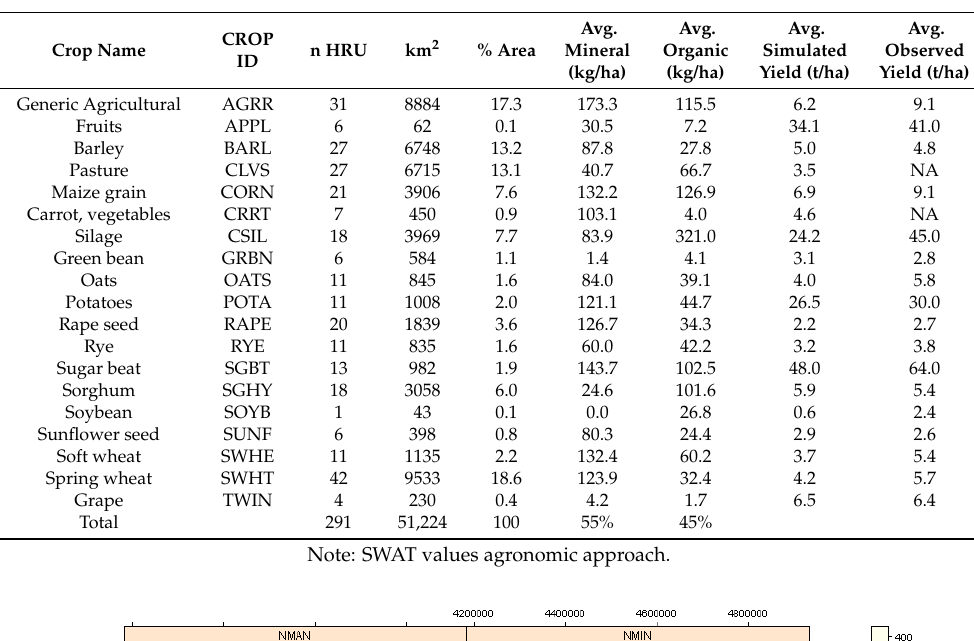
Table 1. Upper Danube Baseline Scenario information related to the crop area and quantity of fertilizer. Avg. Observed yields are derived from EUROSTAT [44].